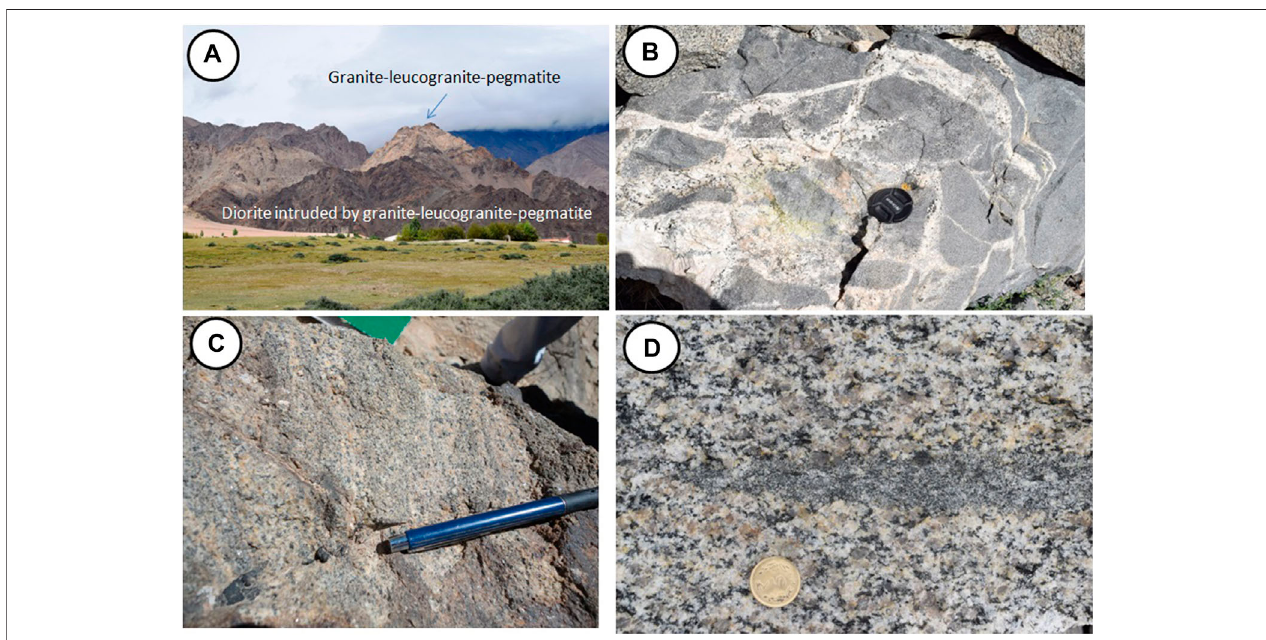
FIGURE 2 | (A) Panoramic view of diorite and granite-leucogranite-pegmatite hills near Sabu, showing the intrusive relationships between them. (B) Diorite is dismembered as xenoliths and partially assimilated by the intruding granite-leucogranite-pegmatite system. (C) Modally graded crude igneous layering shown by alternate bands of ma fi c and felsic minerals in the granite. (D) Biotite granite contains elongated mesocratic fi ne grained facies with diffused boundaries.